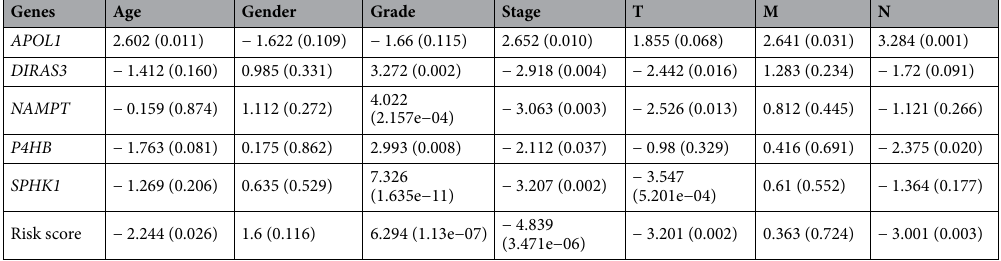
Table 2. Clinical utility of prognostic model related factors [ t -value ( P value)].